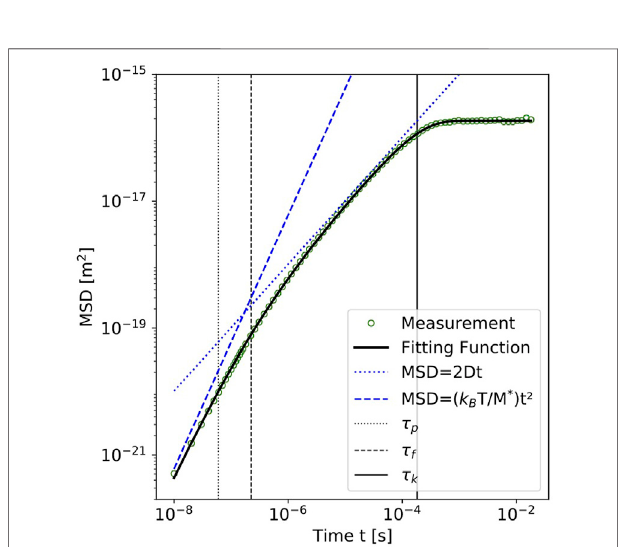
FIGURE 3 | Mean squared displacement determined for the 0 . 915 μ m diameter PMMA particle (see Figure 2 for PSD) at ambient temperature of T 0 (cid:2) 23 ° C. The green circles correspond to the experimental data after binningand subtractionwhile theblacklinedisplaysthetheoretical fi tting function (see Appendix ). The dotted blue line is Einstein ’ s prediction for diffusive motion ( ∝ t ) while the dashed blue line is for ballistic motion ( ∝ t 2 ) . The vertical black lines denote the characteristic time constants of a Brownian particle in the trap. The momentum relaxation time τ p (cid:2) M / ( 6 πη R ) (cid:2) 59 ns, τ (cid:2) 224 ns and τ (cid:2) 6 πη R / k (cid:2) 183 μ s which is the time for the particle to f k move through the trap from one side to the other.